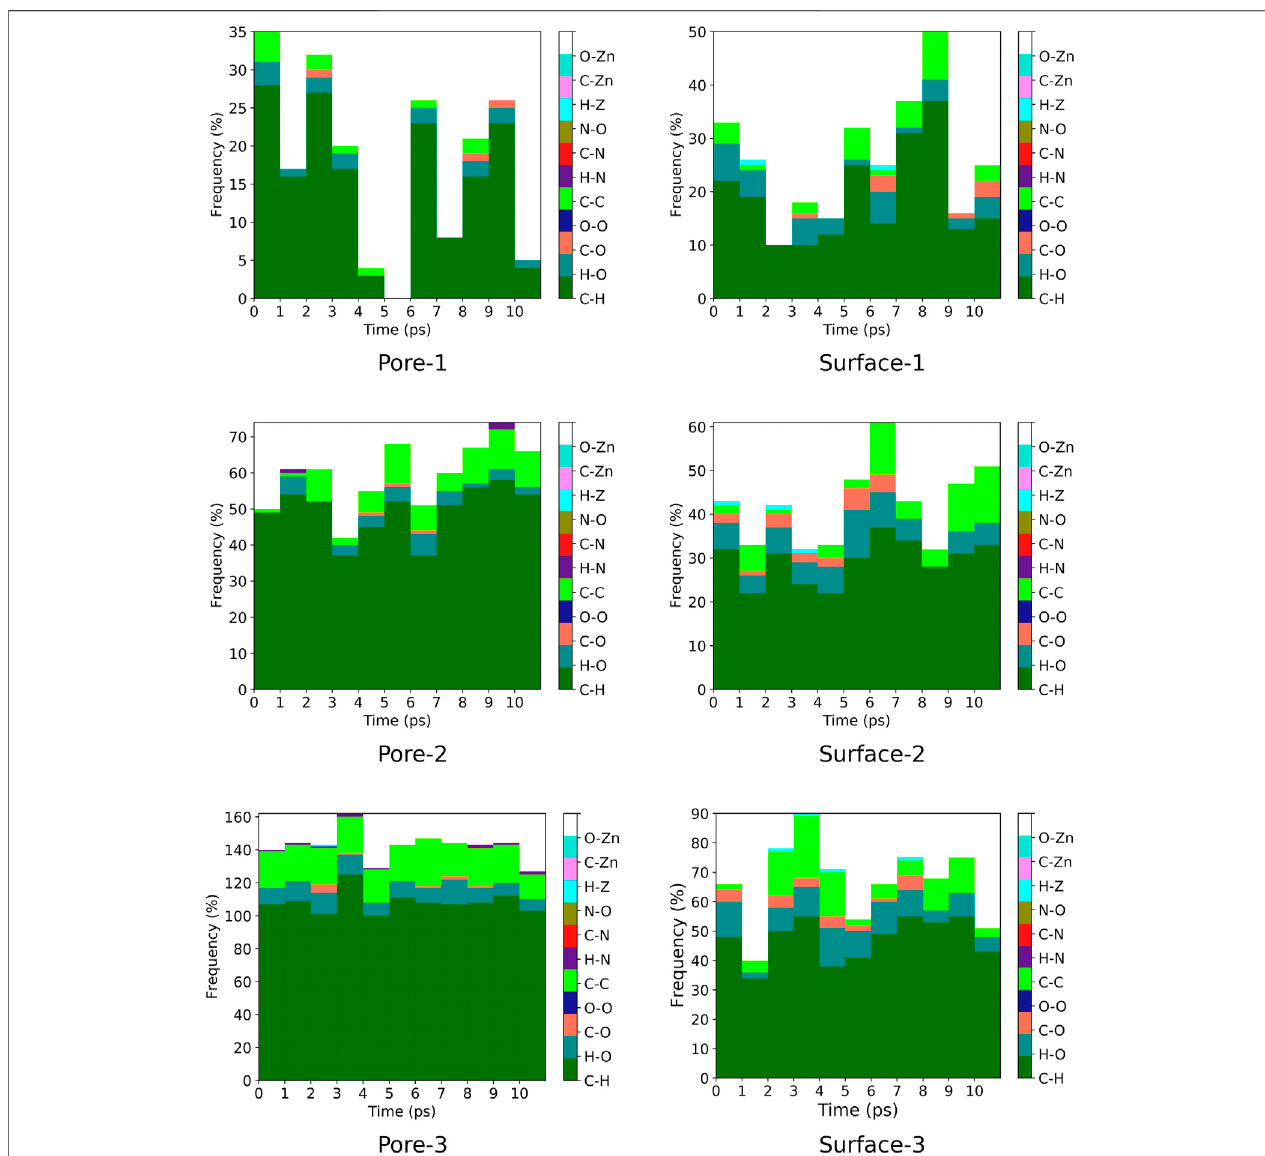
FIGURE 8 | Frequency of ZnPW I styrene intermolecular distances (r < 3.5 Å) for nanochannel and surface interactions. The colour gradient corresponds to speci fi c interatomic interactions and each column correspond to a molecular dynamic trajectory snapshot. Interactions were computed at every 10 ps for systems representing nanochannel interactions and every 1 ps for systems representing surface interactions. The labels ” Pore ” and ” Surface ” correspond to nanochannel and surface interactions respectively and the numbers after the hyphen correspond to the number of monomer(s) present.